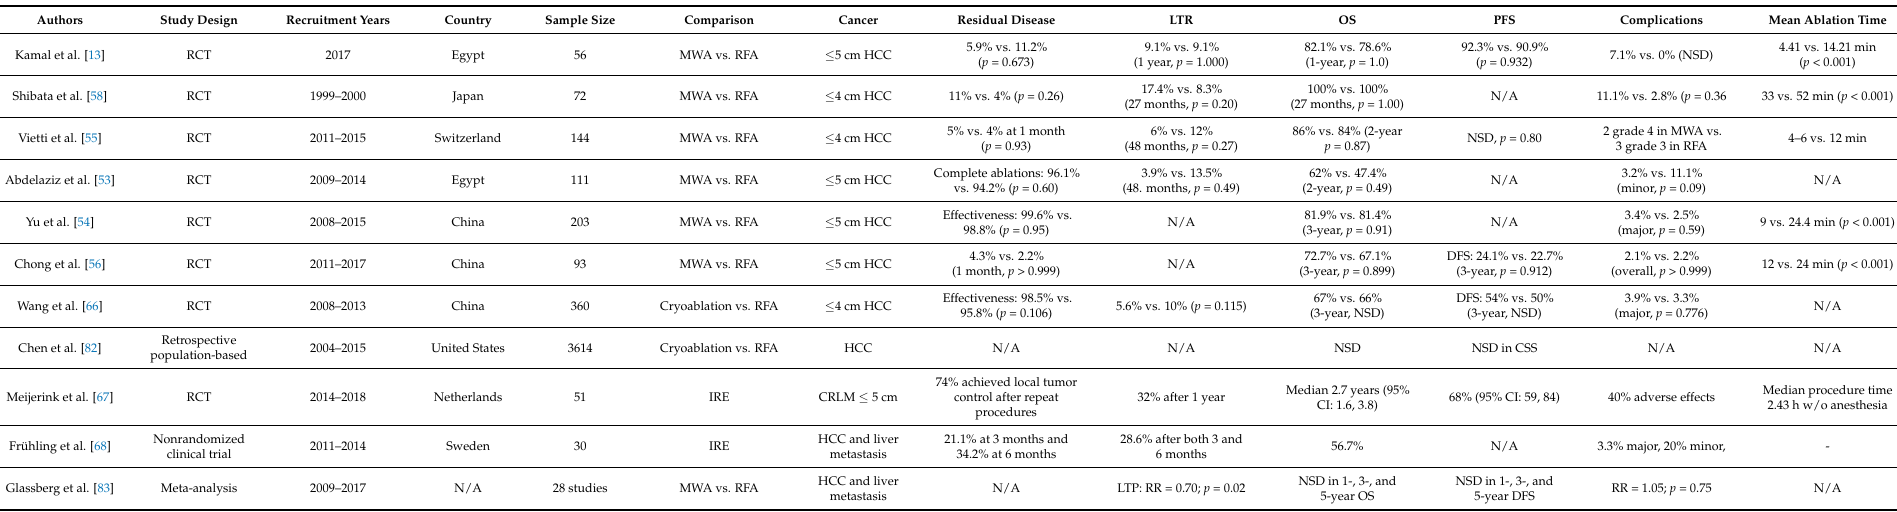
Table 2. Comparison of ablation modalities for hepatocellular